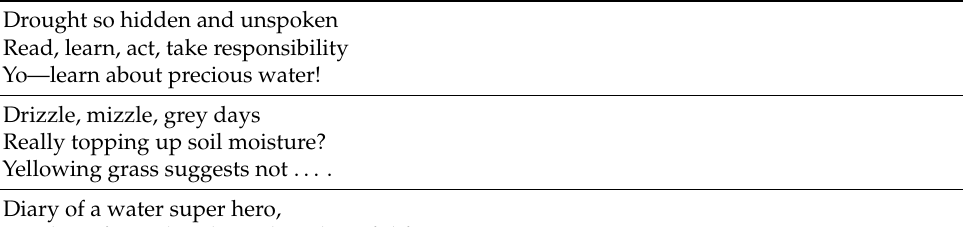
Table 2. Examples of acrostic poetry (nicknamed ‘DRYkus’) generated during the engagements with the DRY picture